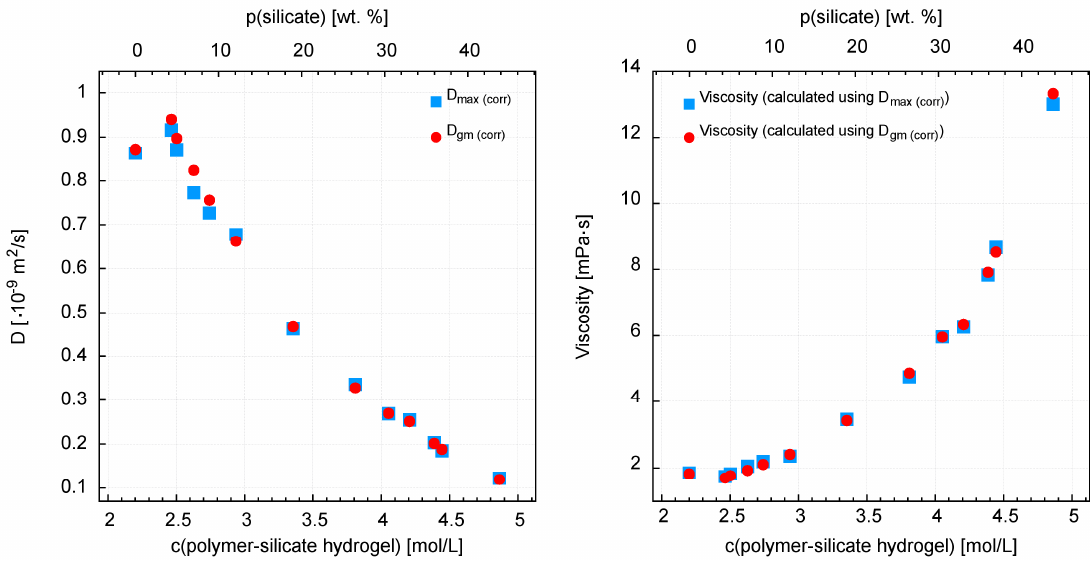
Figure 10. Decrease of diffusion coefficient for the polymer-silicate hydrogels and corresponding viscosity values.